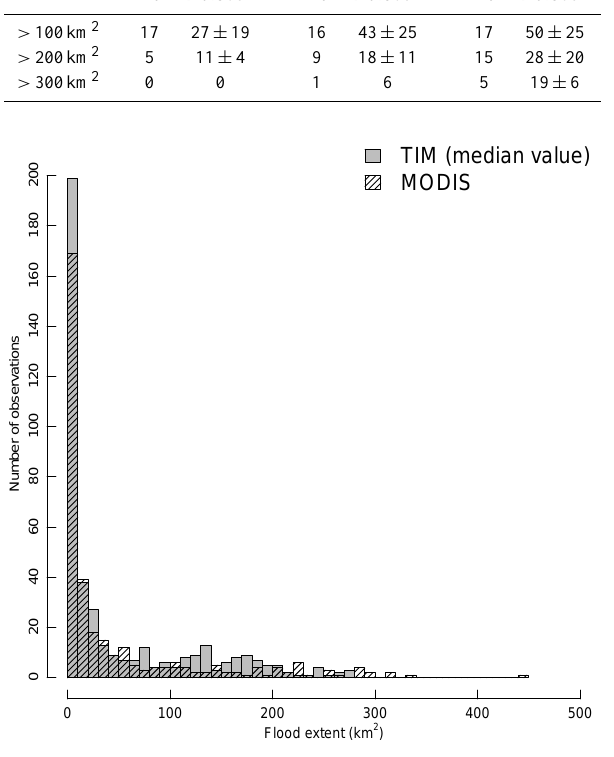
Fig. 8. Histogram of flood extents calculated from the TIM and MODIS images. Counts were conducted every eight days. To- tal numbers of counts were 413 and 338 for TIM and MODIS, respectively.